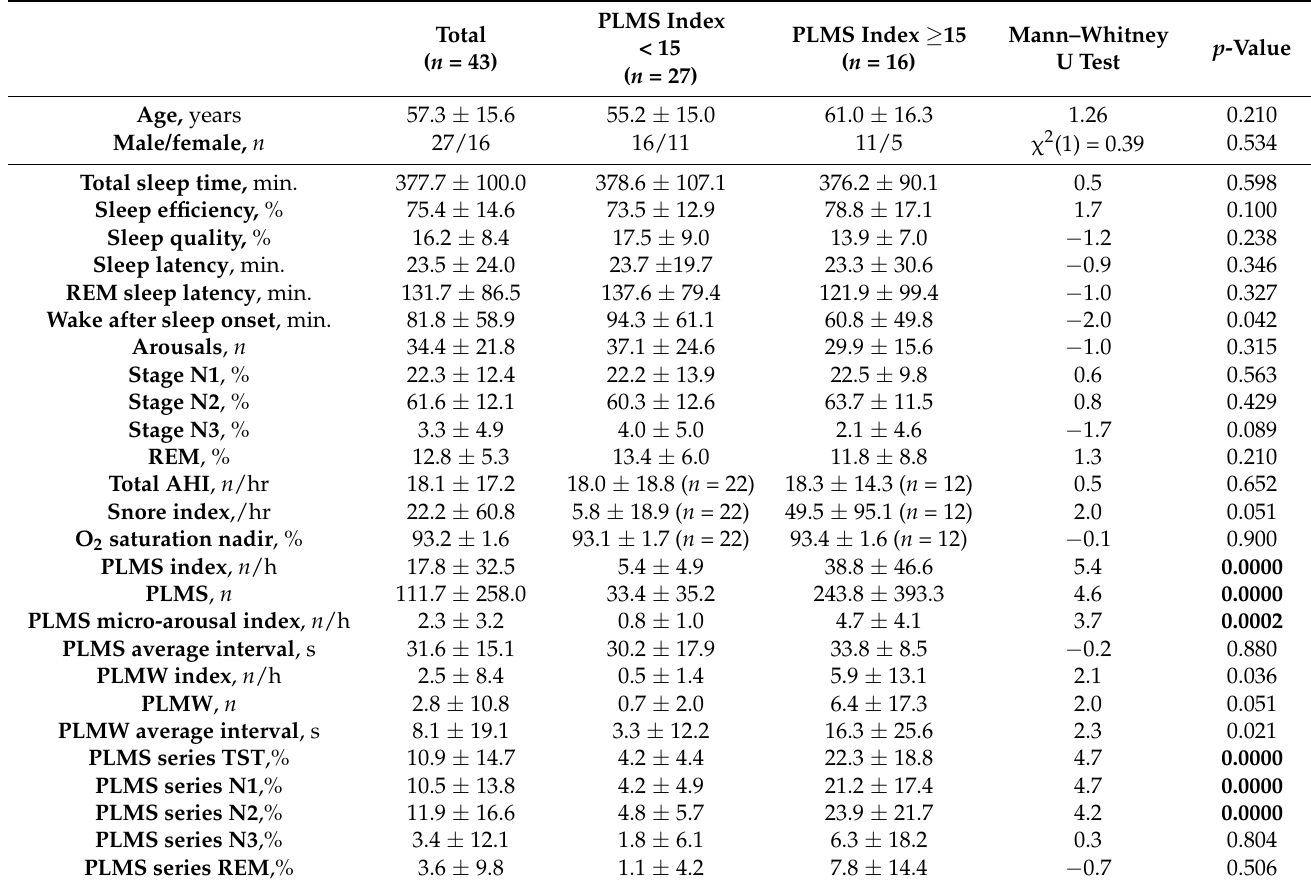
Table 1. Standard sleep study parameters of the